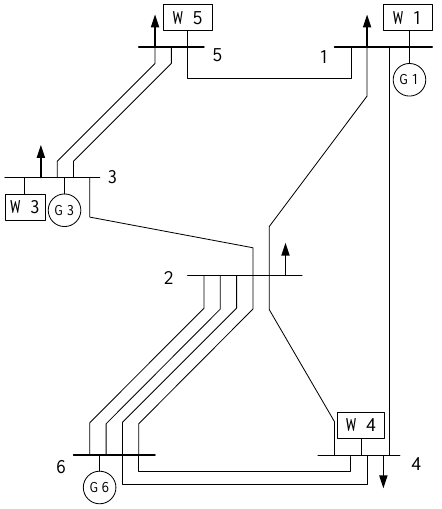
Figure 2. Topology of modified Garver 6-bus system. Table 1. Information of Wind Farms